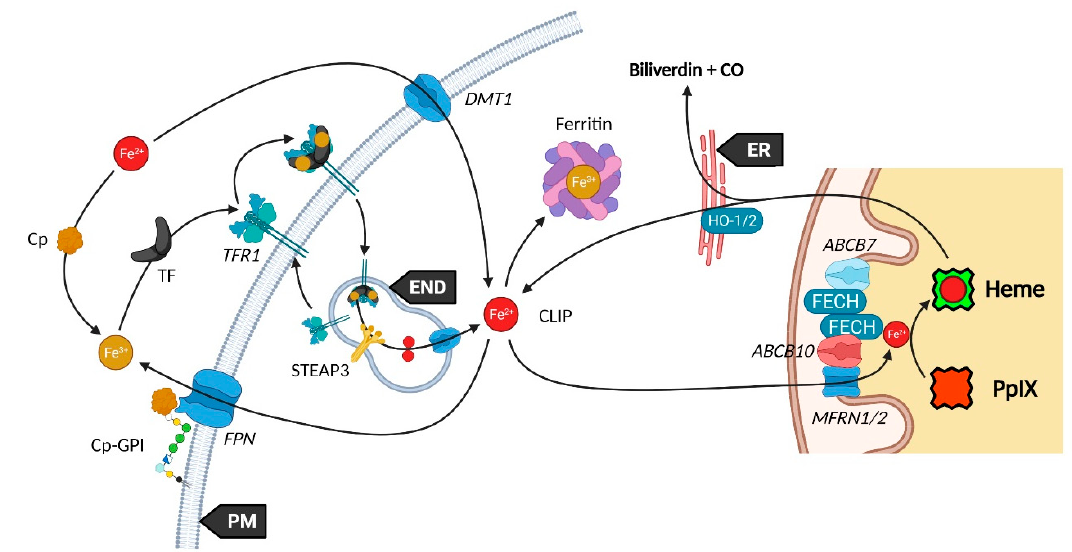
Figure 2. Utilization and regulation of the cytosolic labile iron pool.